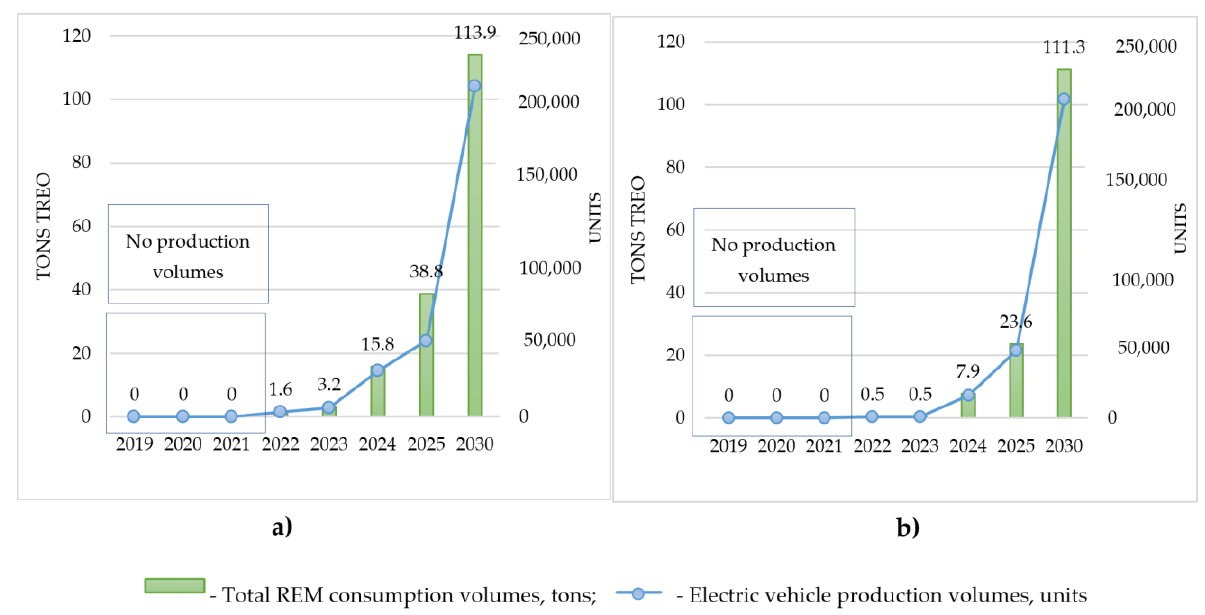
Figure 6. Forecasted REM consumption ( a ) in the implementation of the plans announced by the state for the production of electric vehicles; ( b ) in the implementation of the plans announced by the state for the production of electric vehicles without taking into account the ZETTA electric vehicle that does not require REMs.